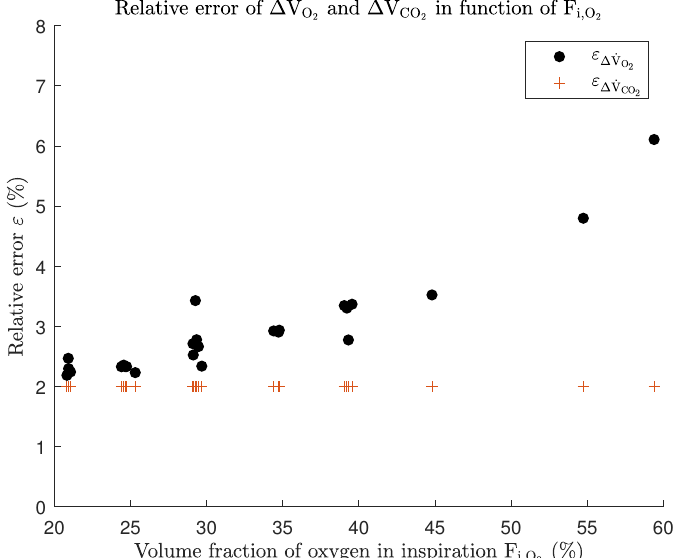
Figure 11. The relative error ε in % of ∆ ˙ V O volume % when using the Haldane